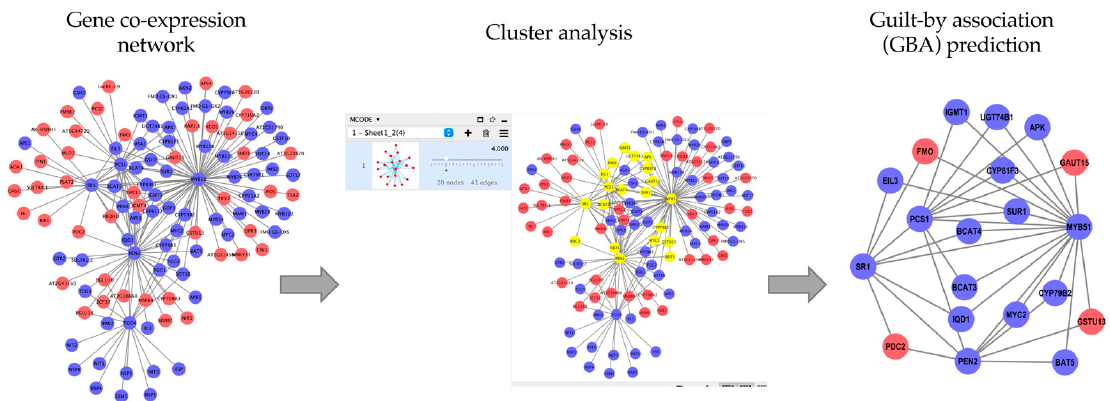
Figure 2. The application of GBA in identifying potential genes. First, a correlation analysis will be calculated to determine the co-expressed genes. Then, the generated GCN will be used in the clustering analysis using clustering tools, such as, MCODE, to extract the densely connected regions (yellow nodes). The GBA approach can elucidate the potential genes (red nodes) with the co-expressed known genes (blue nodes). The blue nodes are known to be involved in glucosinolate biosynthesis, which can be used to infer the red nodes as potential genes in glucosinolate biosynthesis.